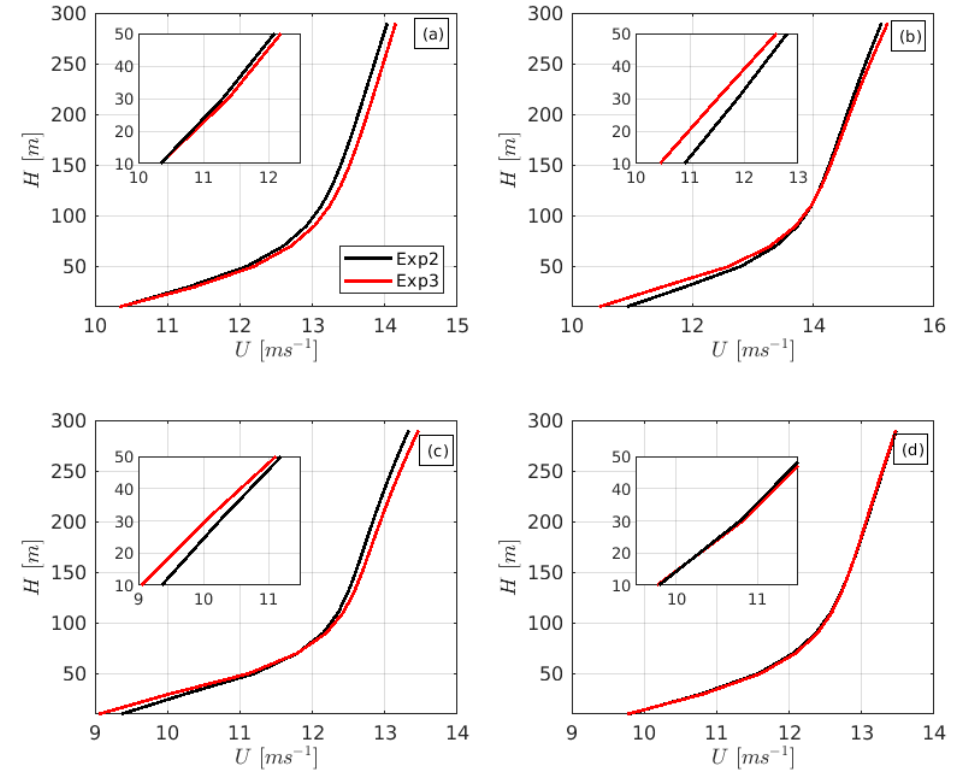
Figure 14. The mean wind profile in January from Exp2 and Exp3 at the four chosen areas: ( a ) A, ( b ) B, ( c ) C and ( d ) D. The insert plots show in the wind profile below 50